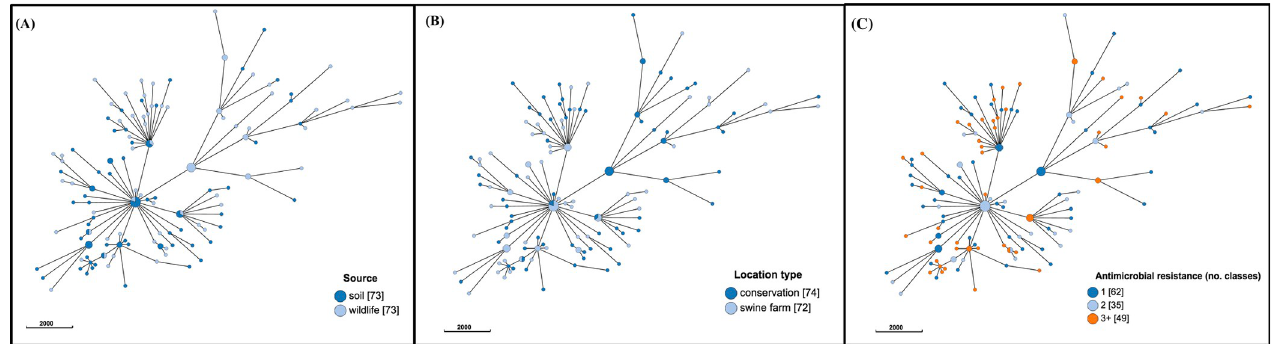
Fig 4. Population structure of 146 Escherichia coli isolates (dataset B) from wildlife and soil on swine farms and conservation areas in southern Ontario based on 2513-loci cgLMST scheme from Enterobase. Minimum spanning tree created using k = 50 clustering threshold in GrapeTree . (A) Distribution of sources. (B) Distribution by location type. (C) Antimicrobial resistance by number of drug classes. Frequency counts are in square brackets. Bubble size is proportional to the number of isolates in each cluster, and each cluster contains isolates differing at a maximum of 50 cgMLST loci.